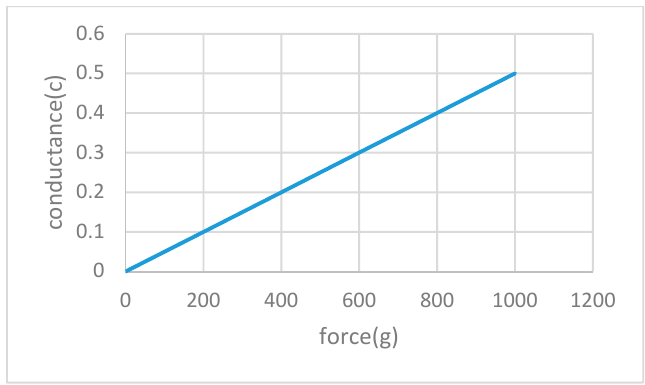
Figure 10. Linear relationship between the force and conductance of the bonded sensor.